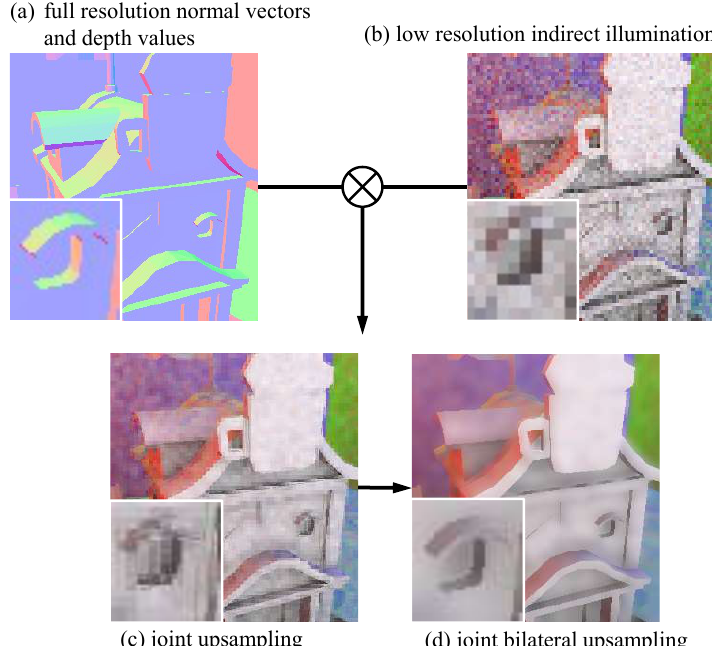
Figure 11. Joint upsampling